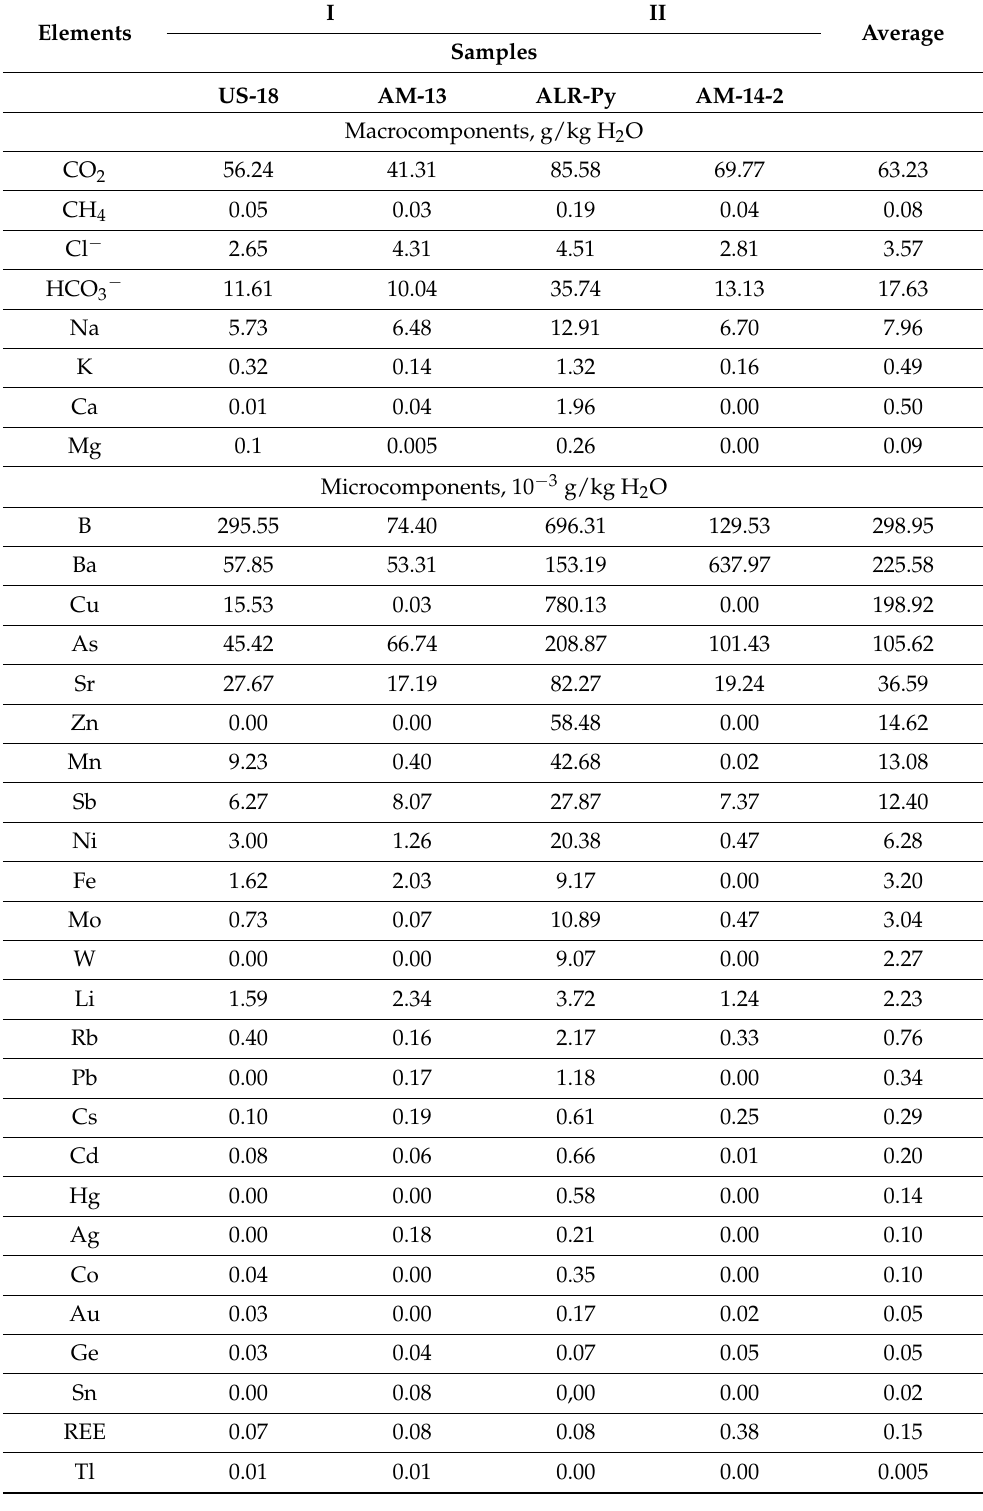
Table 4. Element composition of fluid inclusions of the Ulug-Sair